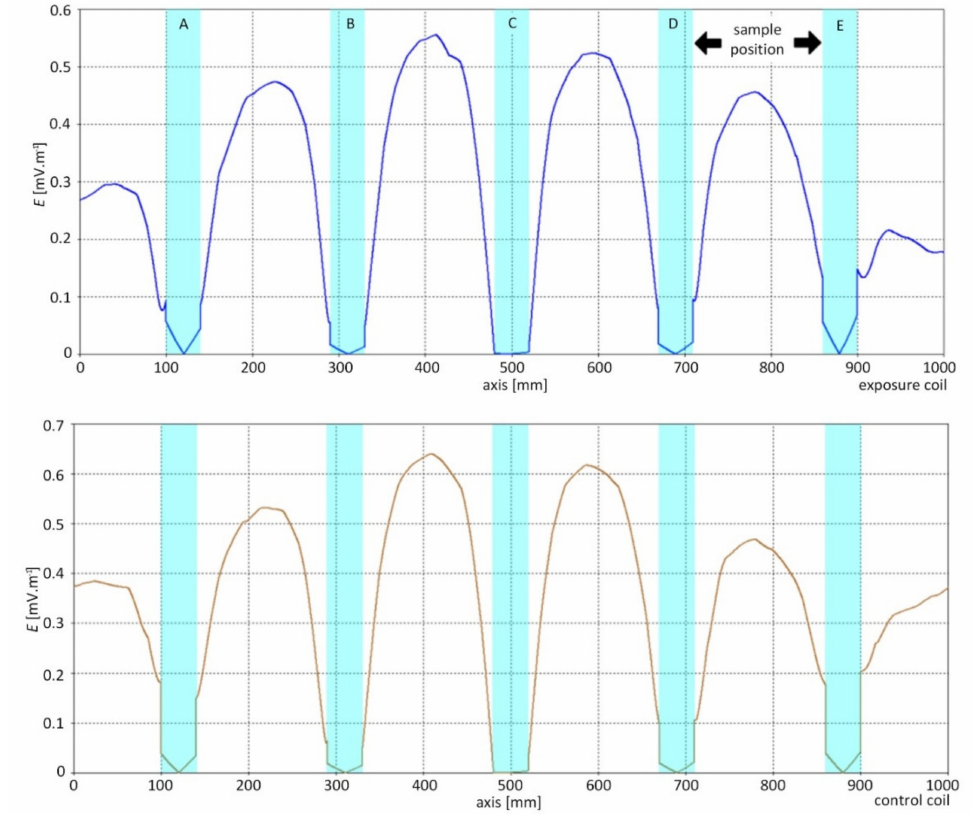
Figure 4. Electric field distribution in exposure and control coil, data from CST Studio